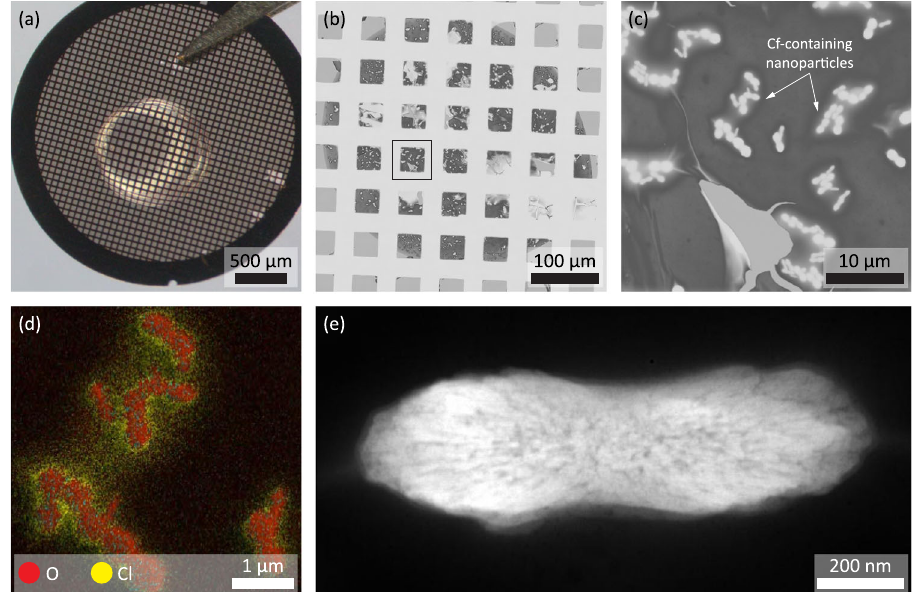
Fig. 1 Investigation of a dropcast Cf-containing sample. a Droplet of a solution containing Cf on a TEM grid. b The dried drop is imaged using the STEM detector of an SEM. A box marks the region shown in ( c ), in which individual particles can be seen. d EDS mapping, with O marked in red and Cl marked in yellow, con fi rms that the particles contain O and have Cl-enriched surfaces. Individual spectra also con fi rm that the particles contain Cf (Supplementary Fig. 5). e HAADF-STEM image of individual particles shows the pores.